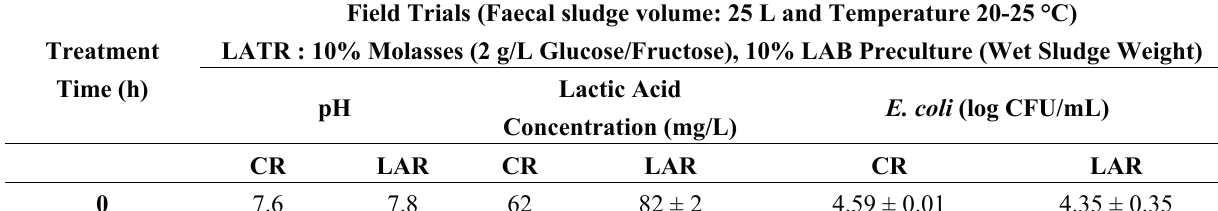
Table 2. Process monitoring of lactic acid fermentation process in the field with sludge 1 (cf. Table